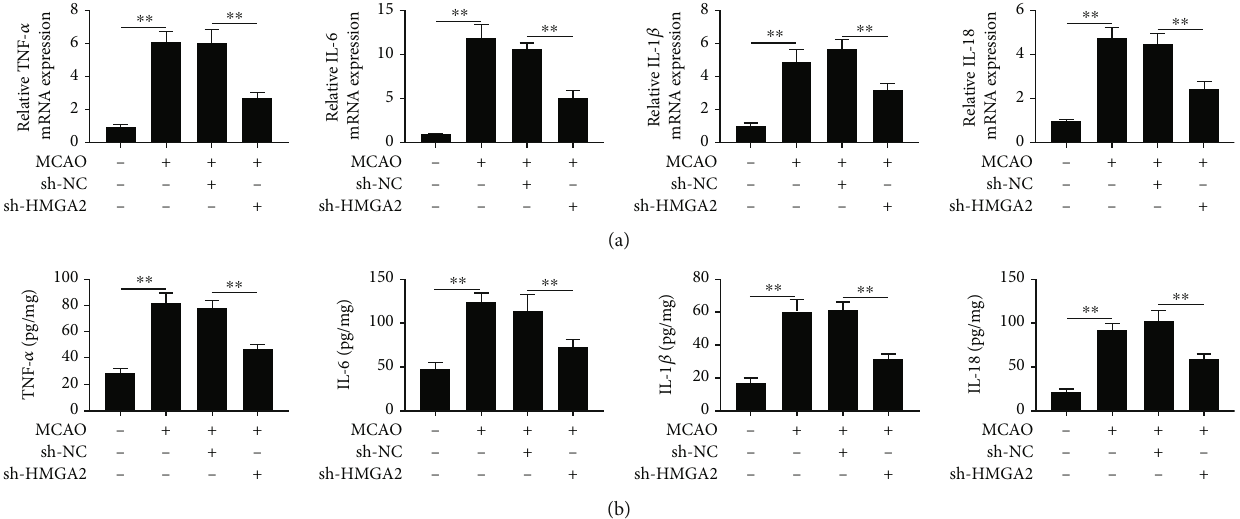
Figure 2: The e ff ects of HMGA2 on brain injury induced in fl ammatory response. (a) Quantitative PCR was performed to examine the mRNA expression level of TNF- α , IL-6, IL-1 β , and IL-18 cerebral infarction. (b) Western blot was used to explore the protein expression level of TNF- α , IL-6, IL-1 β , and IL-18 after cerebral infarction. ∗∗ p < 0 : 01 vs. sham or MCAO + sh-NC. Data are expressed as mean ± SEM .